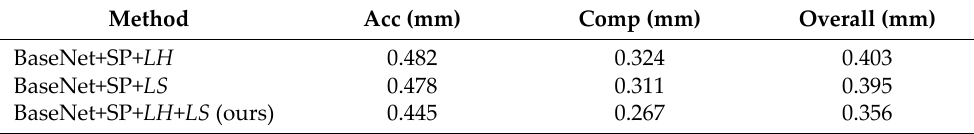
Table 2. The effect of each ablation process on the matching results.